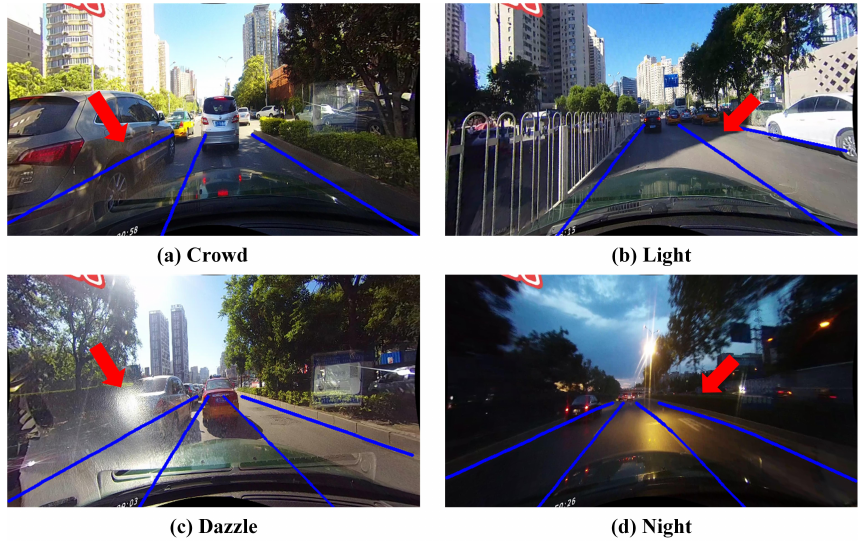
Figure 1. Examples of complex traffic driving scenarios. Some difficult areas are marked with red